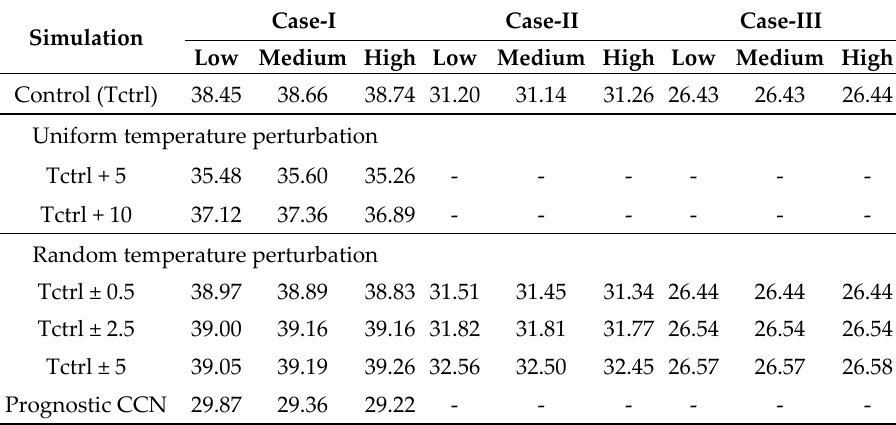
Figure 7. Time series analysis of accumulated rainfall, which is averaged over the domain simulated for the ‘low’ aerosol concentration. As explained in the text, this diagram is very similar for the ‘medium’ and ‘high’ aerosol concentrations. Table 2. Same as Table 1 but for the ice effective radius ( μ